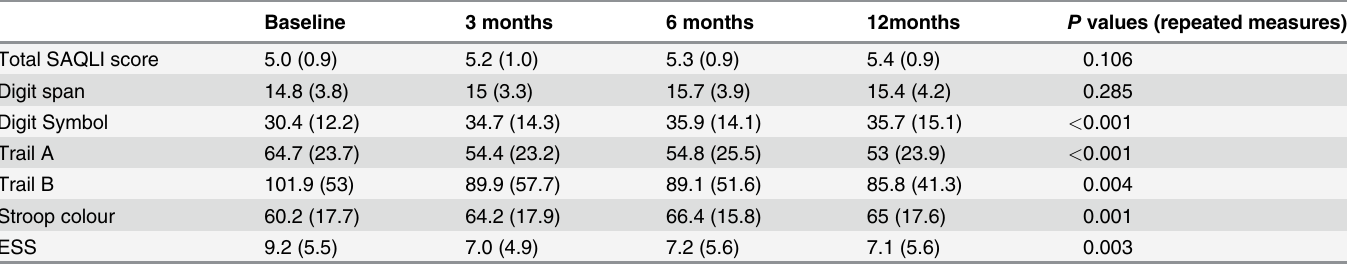
The trail-making test estimated the minimum time required to connect a structured number sequence and the lower the score, the better the performance. The digit symbol and span tests involved the immediate memory and recall of number sequences while the stroop colour test evaluated the correct matching of colour and their corresponding characters. For the stroop colour, digit symbol and span tests, a higher score indicated superior performance. ESS, Epworth sleepiness